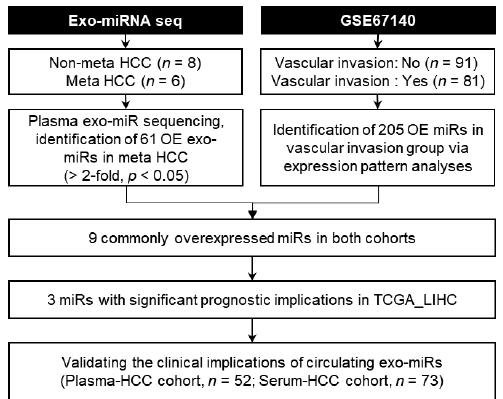
Figure 1. Schematic representation of the systematic integrative analyses performed herein to identify metastasis-stimulating circulating exosomal microRNAs. Exo-miRNA seq, exosomal microRNA sequencing; HCC, hepatocellular carcinoma; Meta, metastasis; exo-miR, exosomal microRNA; OE, overexpressed.